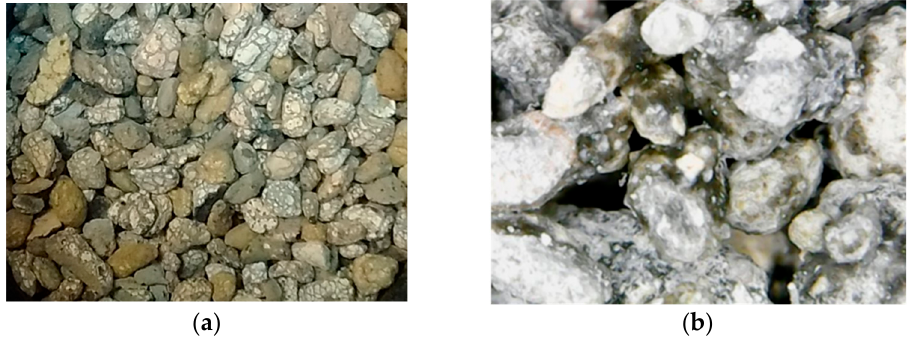
Figure 1. Expanded clay used: ( a ) an overall picture and ( b ) a more detailed image.